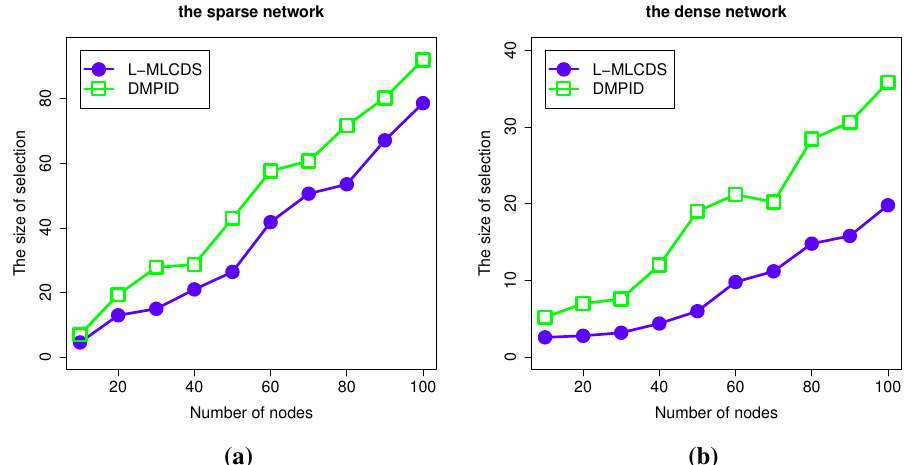
Figure 5. Simulation results for the size of the selection. The size of the selection in ( a ) the sparese network; ( b ) the dense